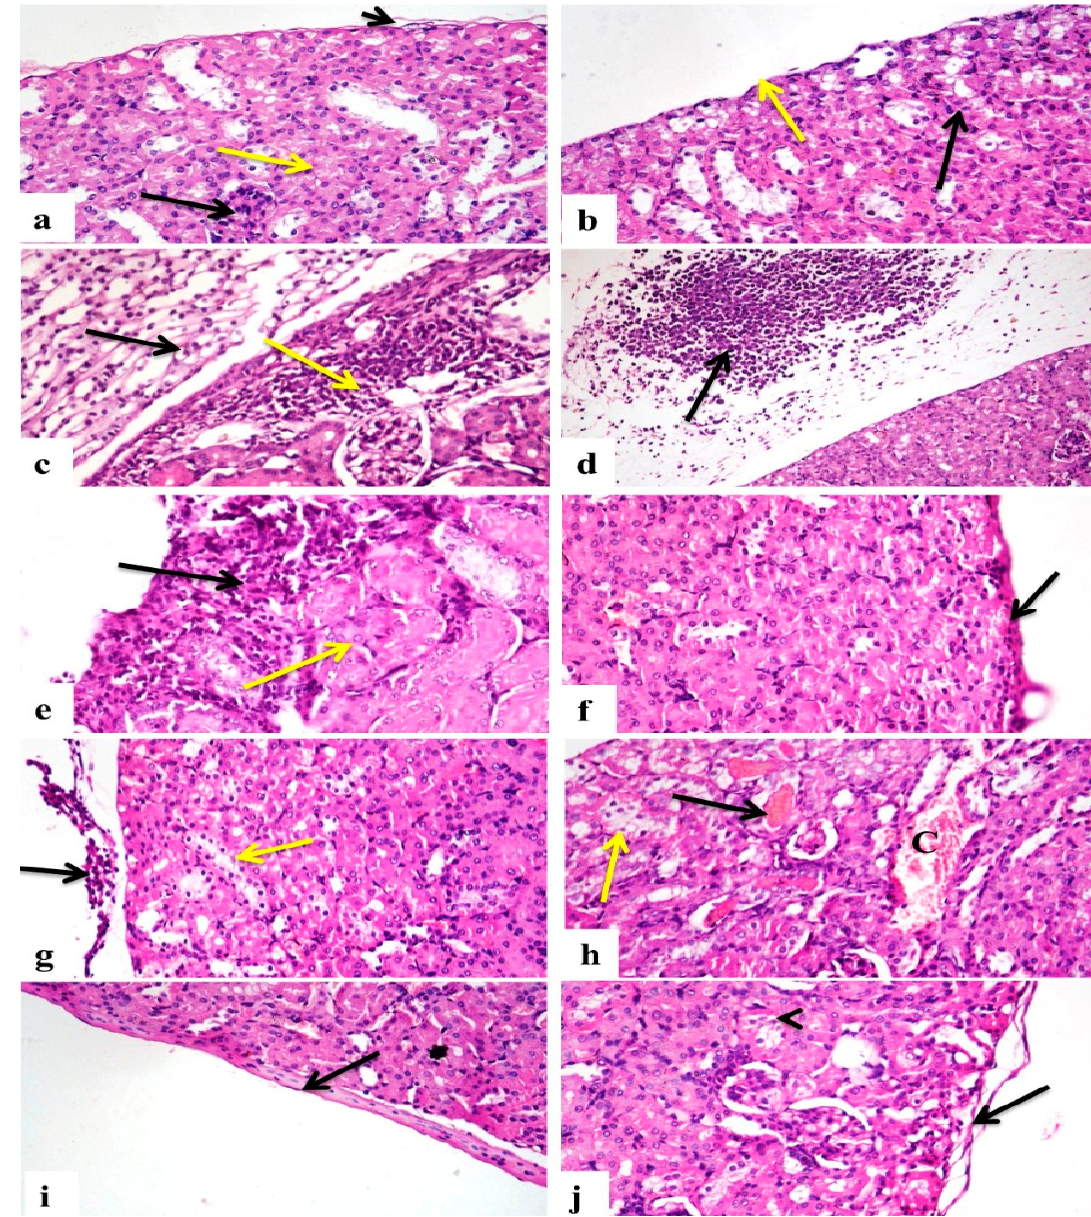
Figure 3. Photomicrographs of histopathological alterations in kidney sections of different groups (H&E stain ×400). ( a ) Control and ( b ) Hesp groups showing normal structure of renal corpuscles (black arrow), tubules (yellow arrow), and capsule (short arrow). ( c ) EAC group showing mononuclear inflammatory cells (yellow arrow), edema, and inflammatory cells in capsule (black arrow). ( d ) EAC group showing infiltration of cancer cells in capsule (arrow). ( e ) Hesp-protected group showing mononuclear inflammatory cells (black arrow) with normal tubules (yellow arrow). ( f ) Hesp-protected group showing capsule free of neoplastic cells (arrow). ( g ) Hesp-treated group showing infiltration of capsule with cancer cells (black arrow) with vacuolar degeneration of tubules (yellow arrow). ( h ) Cis-treated group showing necrosis of tubular lining epithelium with presence of hemoglobin cast (black arrow), vacuolar degeneration of tubule (yellow arrow), and congestion of interstitial blood vessels (C). ( i ) Cis-treated group showing capsule free of cancer cells (arrow). ( j ) Cis+Hesp-treated group showing free capsule of cancer cells (arrow) with mild vacuolar degeneration of tubules